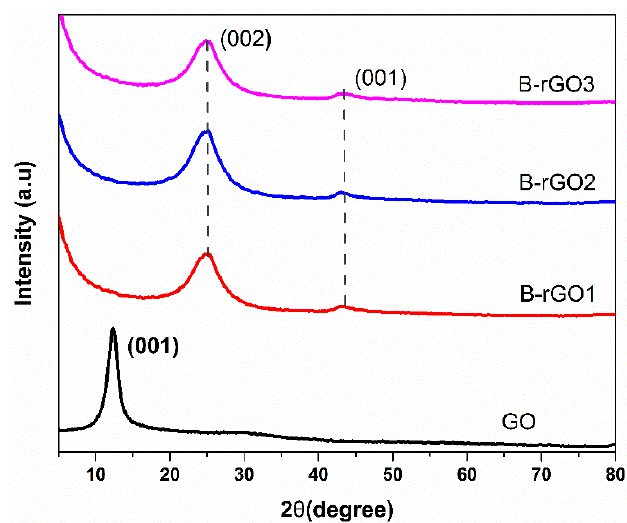
Figure 4. The XRD pattern of the synthesized GO, doped B-rGO1, B-rGO2, and B-rGO3 powder samples.